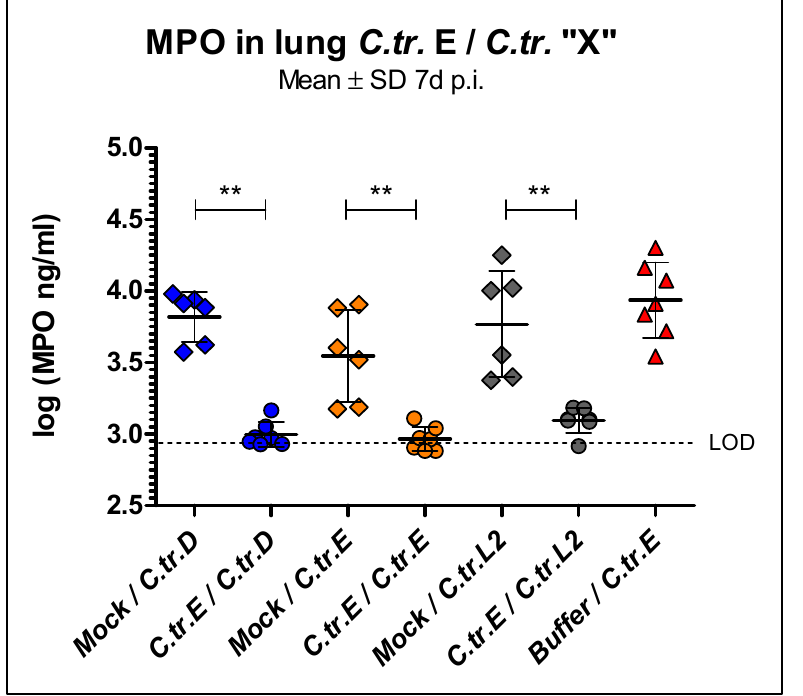
Figure 4. Mice infected i.n. with C.tr. serovars D, E, and L2 show lower myeloperoxidase (MPO) concentrations in lung homogenate after overcoming a primary lung infection with C.tr. serovar E. Animals previously i.n. infected with C.tr. genital serovar E or mock material ( n = 6–7) were infected a second time with the C.tr. serovars D, E or L2 7 weeks after the primary infection. Mice infected twice with mock material ( n = 4) served as negative control; the MPO-level of all individual control animals was <log(2.95) ng/mL (not shown). Seven days after the second i.n. infection with C.tr. serovars D, E or L2, mice were painlessly sacrificed and the level of MPO (mean ± SD of log 10 (IFU)) was determined in lung homogenate. LOD: Limit of detection. The performed statistical analysis is described in Section 2. ** indicates statistical significances between the previously mock-infected animal groups and groups initially infected with C.tr. E with p < 0.01.